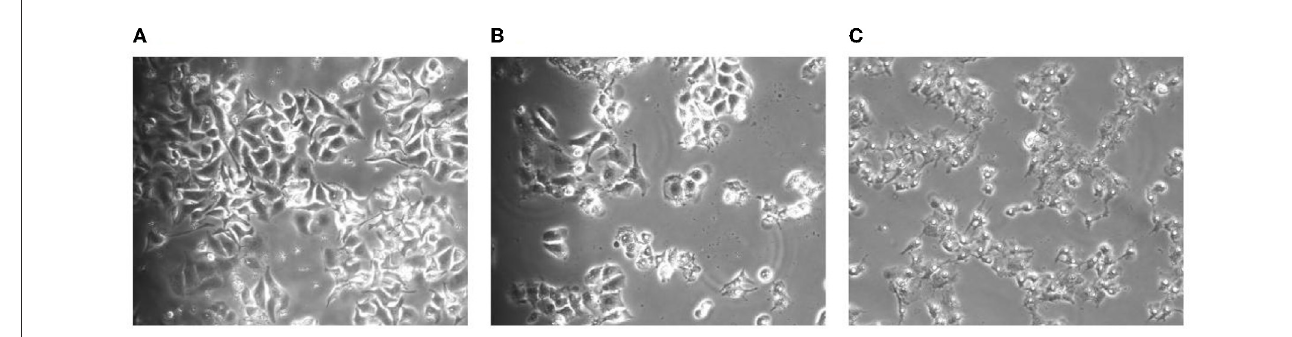
FIGURE1 Morphological changes of the cells after TG treatment for 24h. (A) Cell morphology after treatment with 0 µ g/ml TG. (B) Cell morphology after treatment with 21 µ g/ml TG. (C) Cell morphology after treatment with 42 µ g/ml TG.